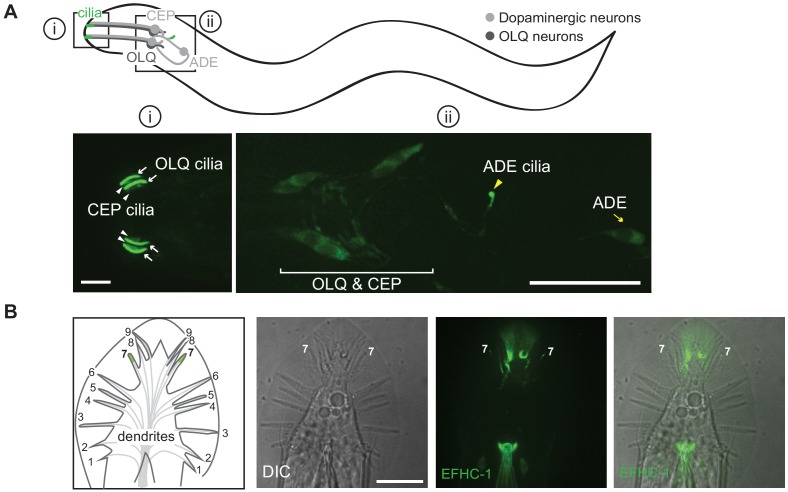
The expression patterns of EFHC-1 in an efhc-1::gfp knock-in strain mirror those seen for the EFHC-1::GFP fusion protein.(A) Endogenously GFP-tagged EFHC-1 is found in dopaminergic and mechanosensory neurons (CEP, ADE, and OLQ). EFHC-1::GFP predominantly accumulates in cilia (white arrows and yellow arrowheads) of OLQ and ADE neurons, but is weakly present in CEP cilia (white arrowheads). Scale bar, 4 μm (i) and 18 μm (ii). (B) EFHC-1::GFP is highly enriched in the distal end of the dendrite in the male tail (ray 7), but it is not observed in the additional dopaminergic ray neurons (possibly due to lower expression levels that are below detection abilities). Scale bar, 18 μm.